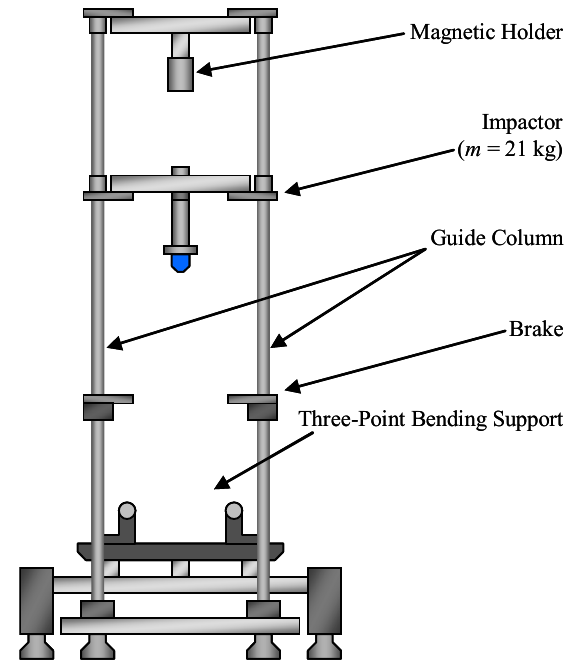
Fig. 1 Schematic diagram of experimental setup. A drop test system is adopted and the impactor is released smoothly by using a magnetic holder. A three-point bending support is placed directly below the